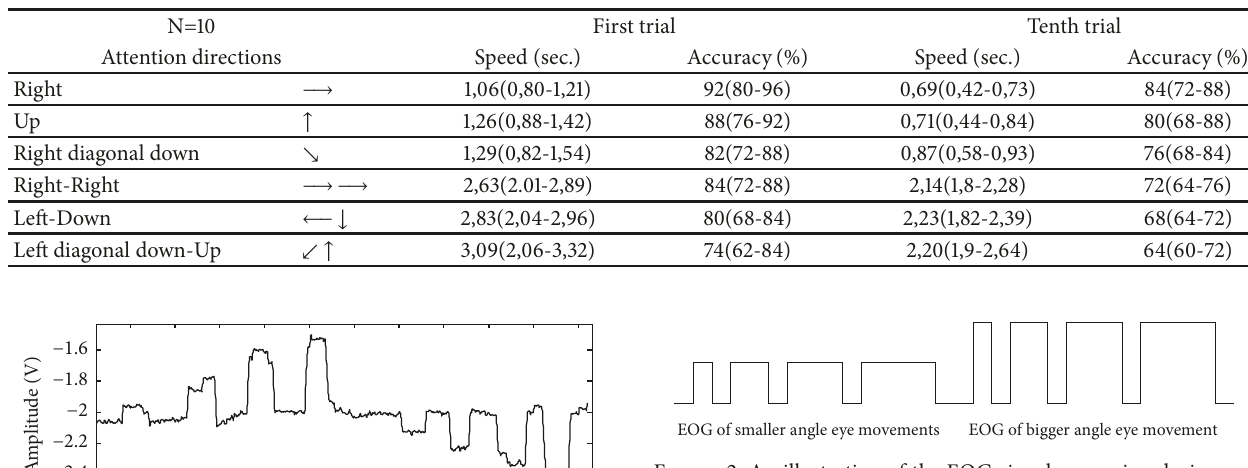
Figure 2: An illustration of the EOG signals emerging during eye movements into one single direction with two different angles and four dwell